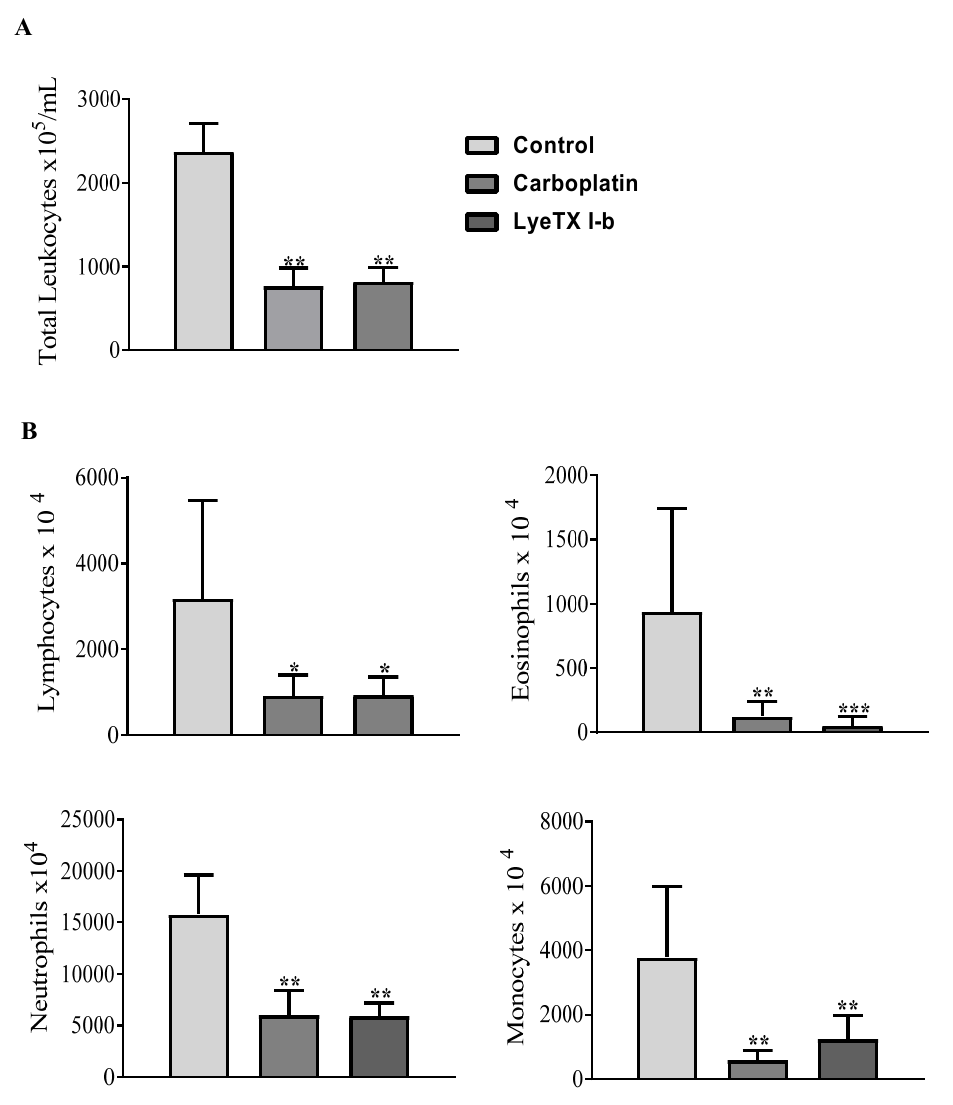
Figure 10. Leukogram of peripheral blood counts in 4T1 tumor-bearing mice. The control received saline, and the other groups received carboplatin or LyeTx I-b (5 mg/kg), five doses every 72 h. ( A ) Total leukocytes count × 10 5 . ( B ) Differential leukocytes count × 10 4 , lymphocytes, eosinophils, neutrophils, and monocytes. LyeTx I-b and carboplatin induced leukopenia in treated groups. Data are presented as the mean ± SD, * p < 0.05; ** p < 0.01; *** p < 0.001 compared to the control group, n = 6 animals.